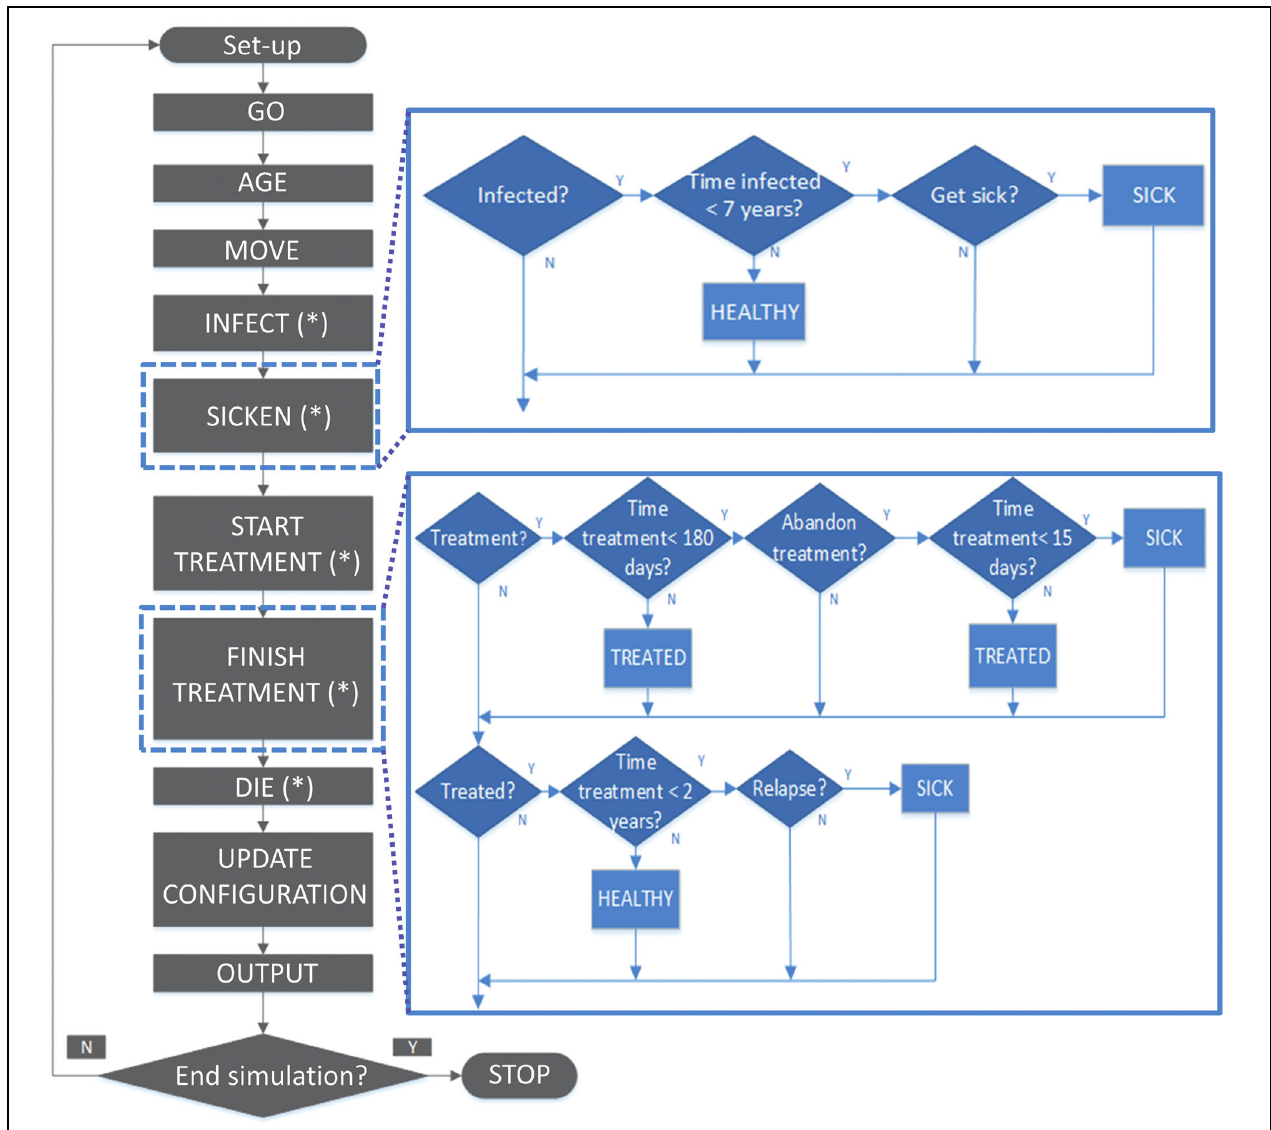
FIGURE 2 | Flow diagram of the model, with all the involved processes and subprocesses. Boxes with an asterisk ( ∗ ) contain actions that can take place if specific conditions are satisfied. Details of two submodels are shown in blue (get sick and finish treatment), see the text for details of other